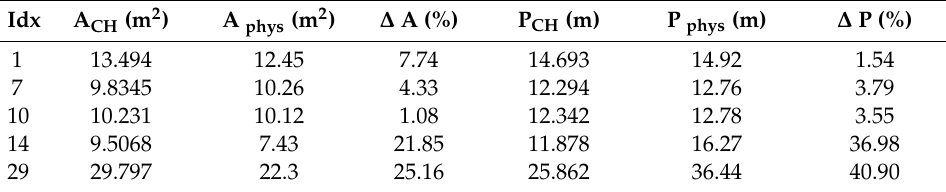
Table 9. Physical area and perimeter, di ff erence in percent from convex hull